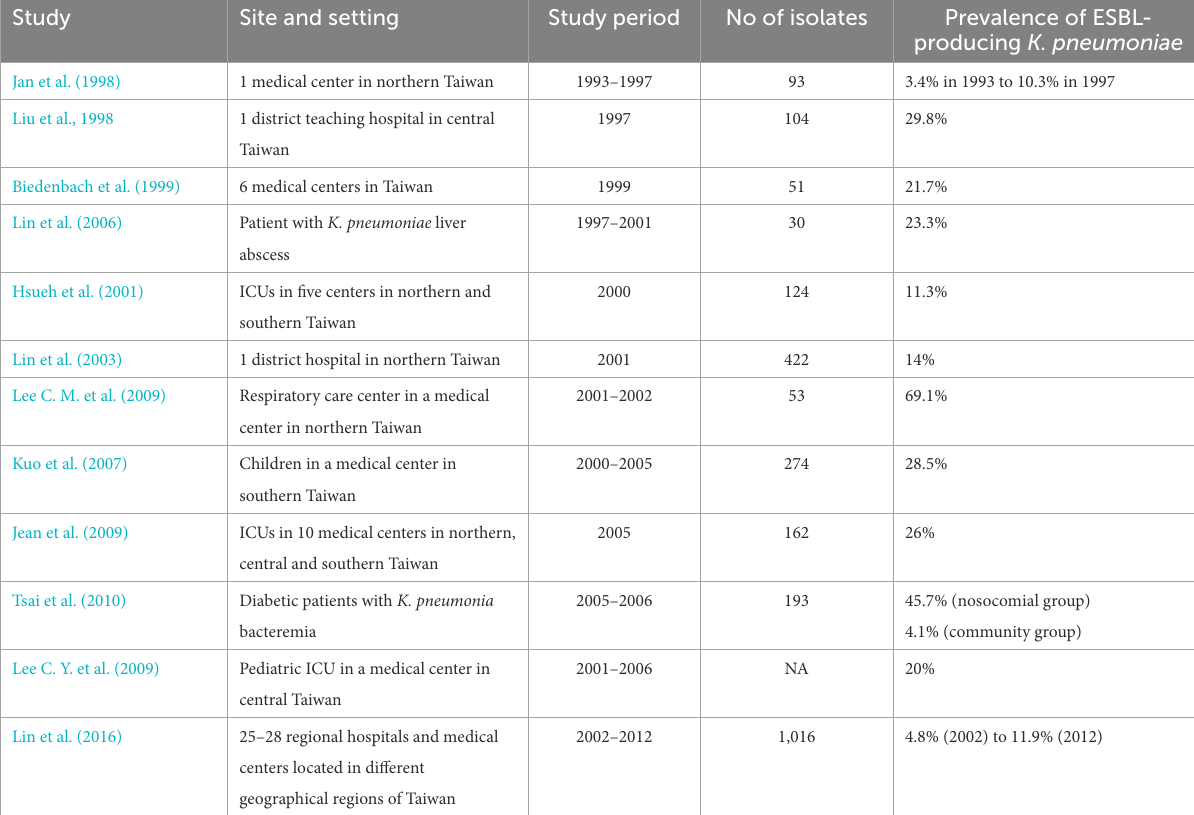
TABLE 4 Prevalence of extended-spectrum β -lactamases (ESBLs) among Klebsiella pneumoniae in Taiwan.